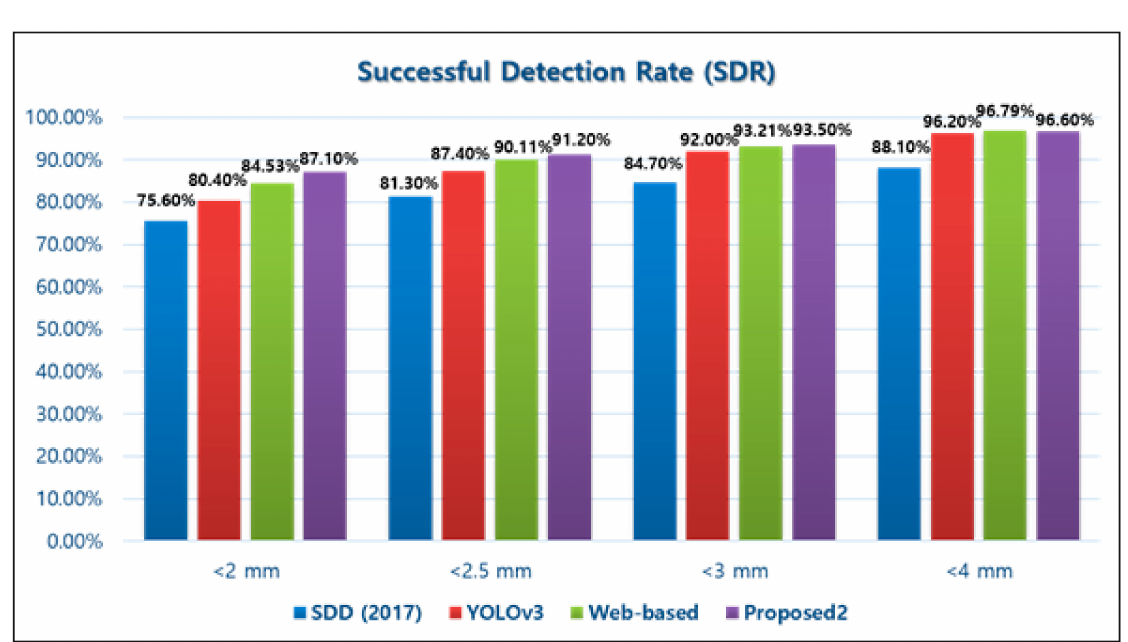
Figure 6. Comparison of successful detection rate of different CNNs architecture based on fully automatic landmark identification